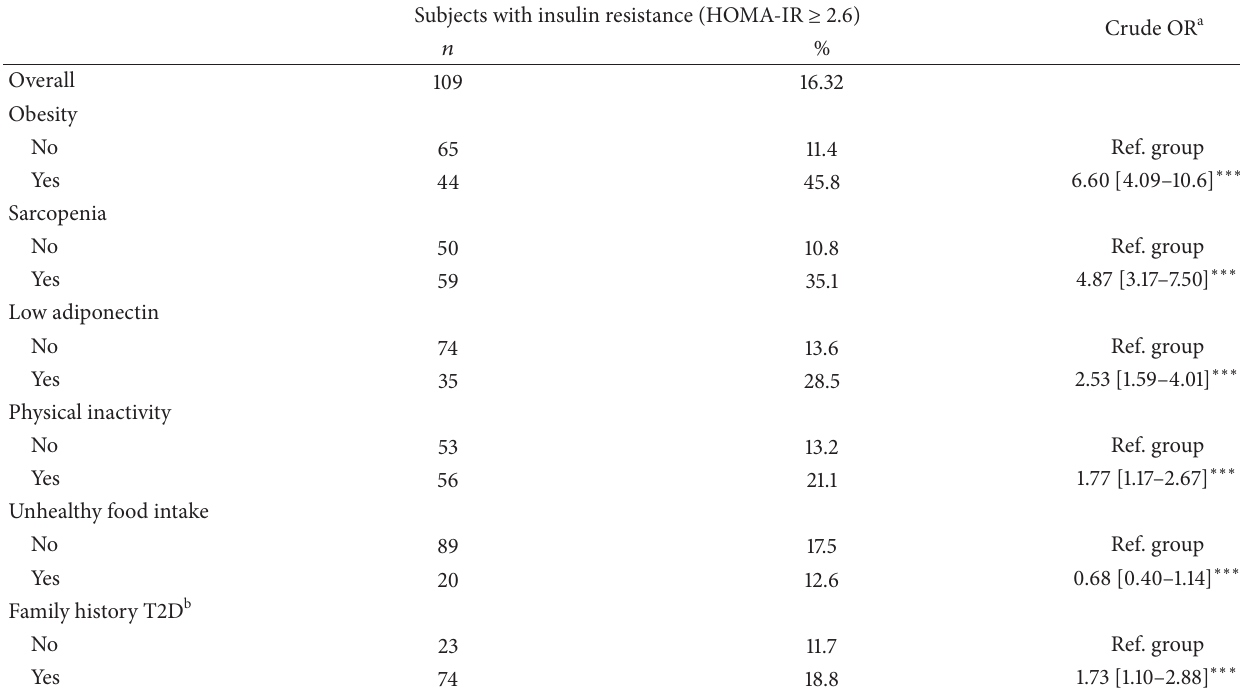
Table 2: Association between IR and sex, obesity, sarcopenia, low adiponectin, life-style habits, and HFDM2 in adolescents ( 𝑛 = 667 ). Subjects with insulin resistance (HOMA-IR ≥